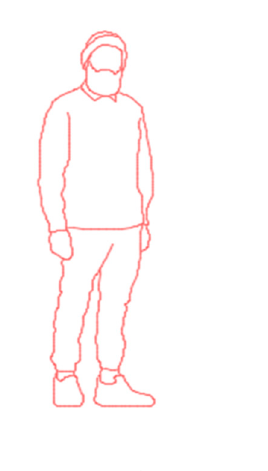
Figure 2. Mounting the IJP sensor at the xiphoid process using adjustable belt and the e-Health sensor at nostril.